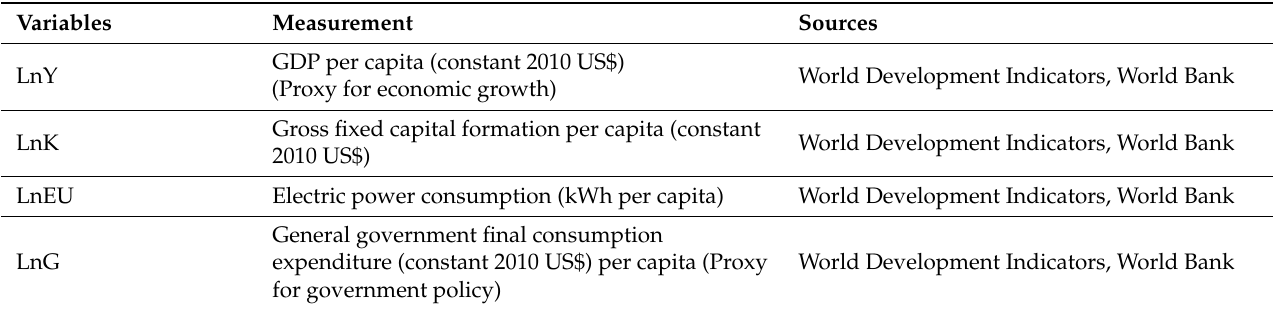
Table 1. Description of